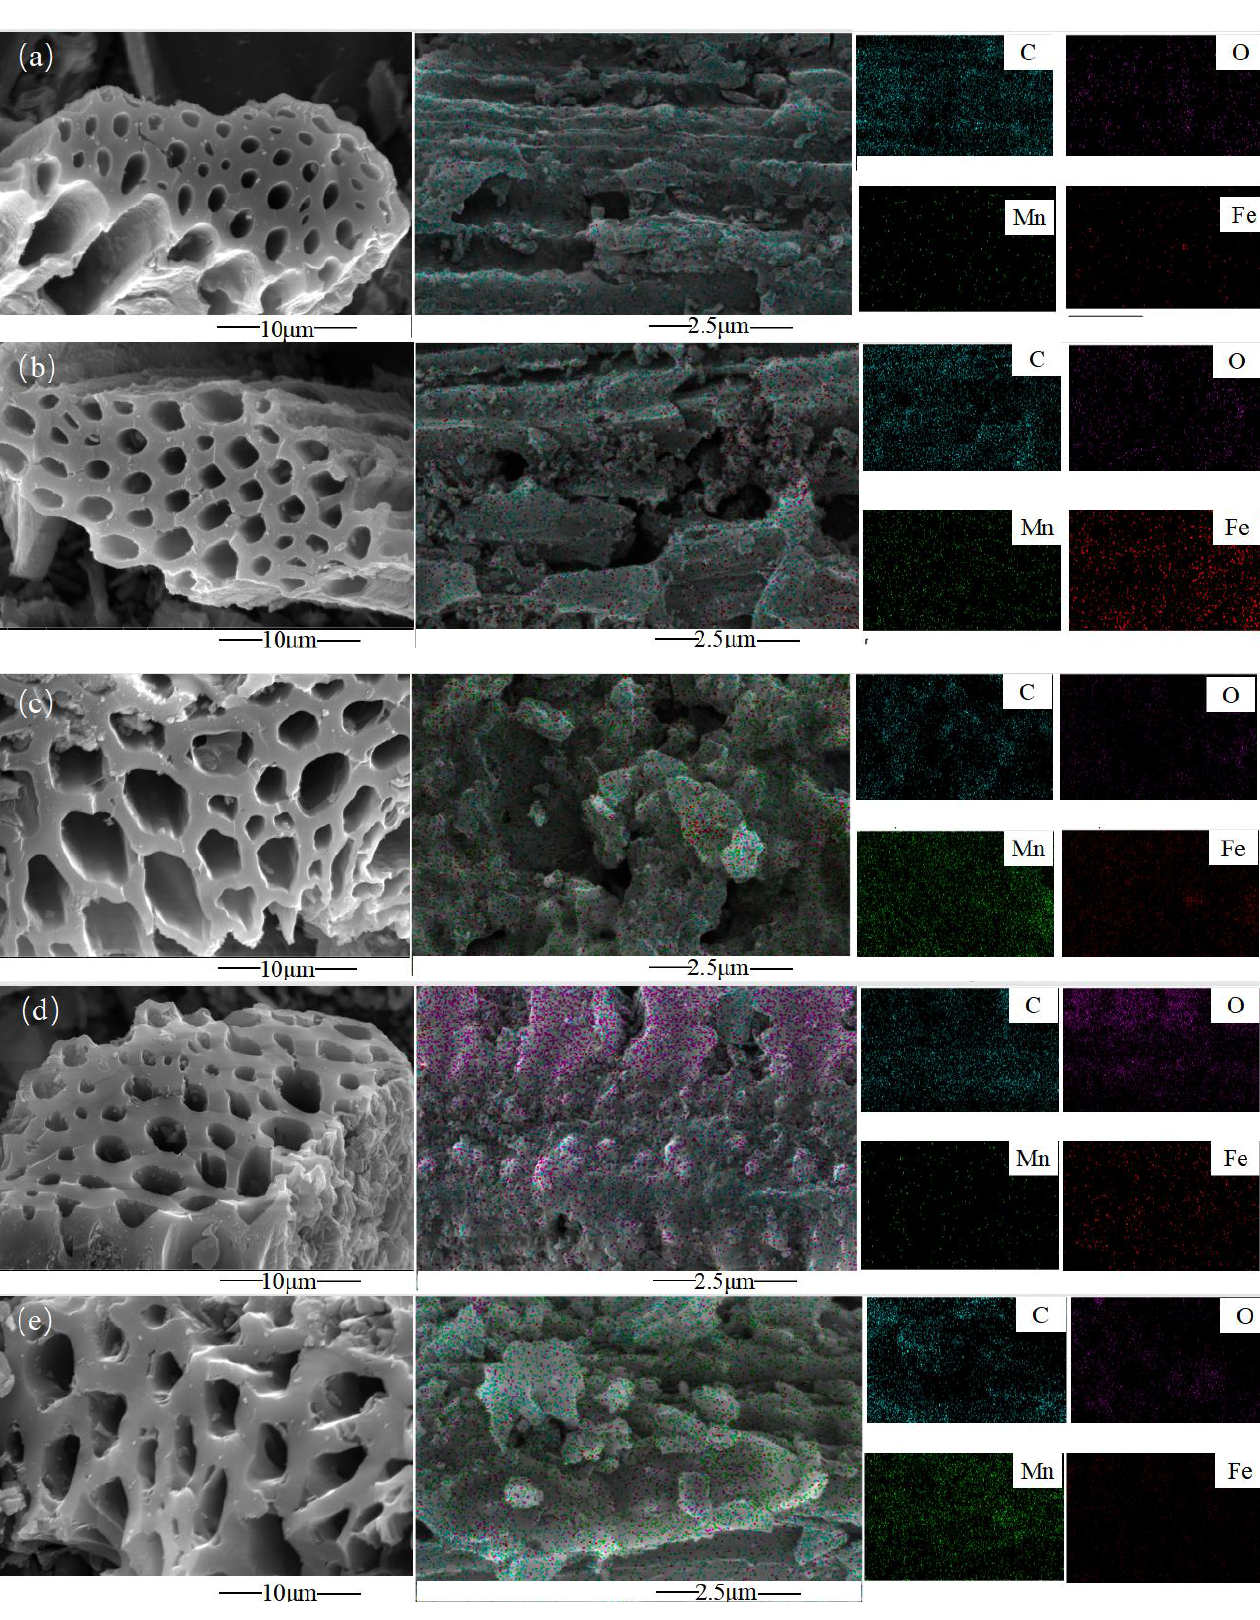
Figure 1. Scanning Electron Micrograph of Original Biochar ( a ), F 3 M 1 DBC ( b ), F 1 M 3 DBC ( c ), FeDBC ( d ), and MnDBC ( e ).